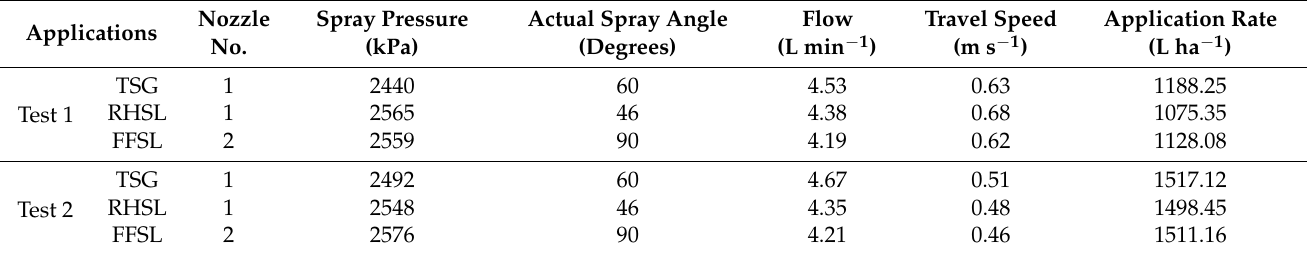
Figure 4. Sampling position (depth and height) for assessing the spray deposition on the canopy and the losses to the ground. Table 2. Spray application parameters for the tests.